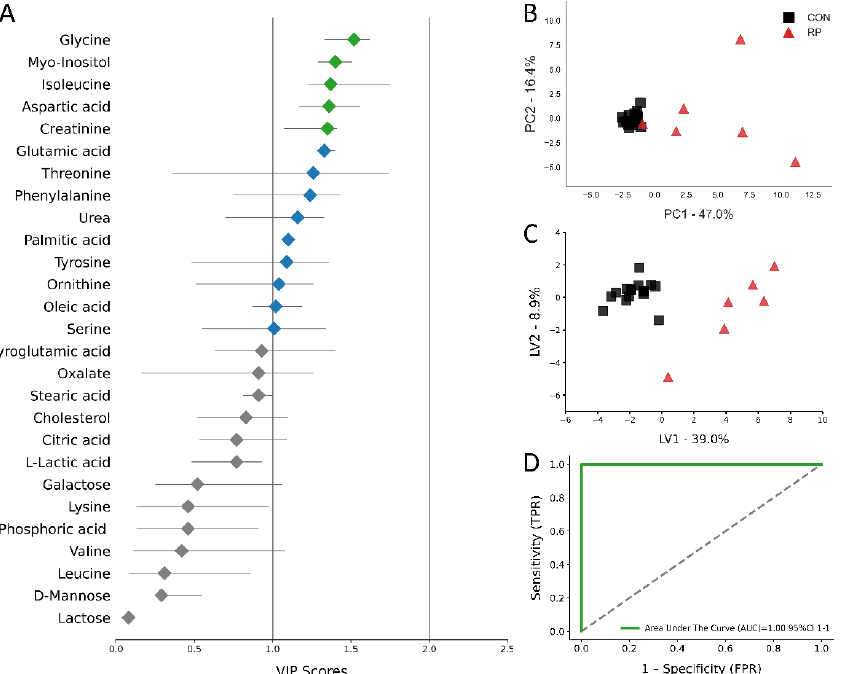
Figure 6. ( A ) Variables ranked by variable importance in projection (VIP), ( B ) PCA, ( C ) PLS-DA (permutation test: p < 0.05) of 16 healthy control (CON) cows and 6 RP cows at the week of RP diagnosis. ( D ) ROC curve for five top-performing metabolites in Vip Scores.